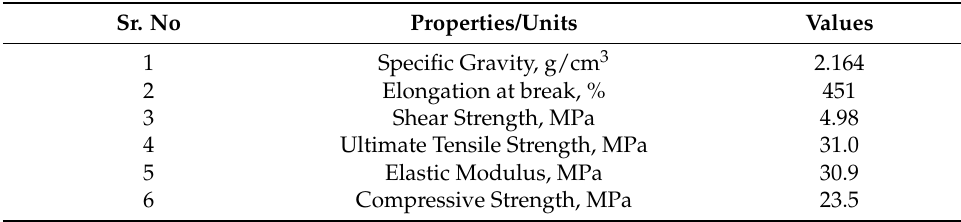
Table 3. Physical, Rheological, and Mechanical properties of